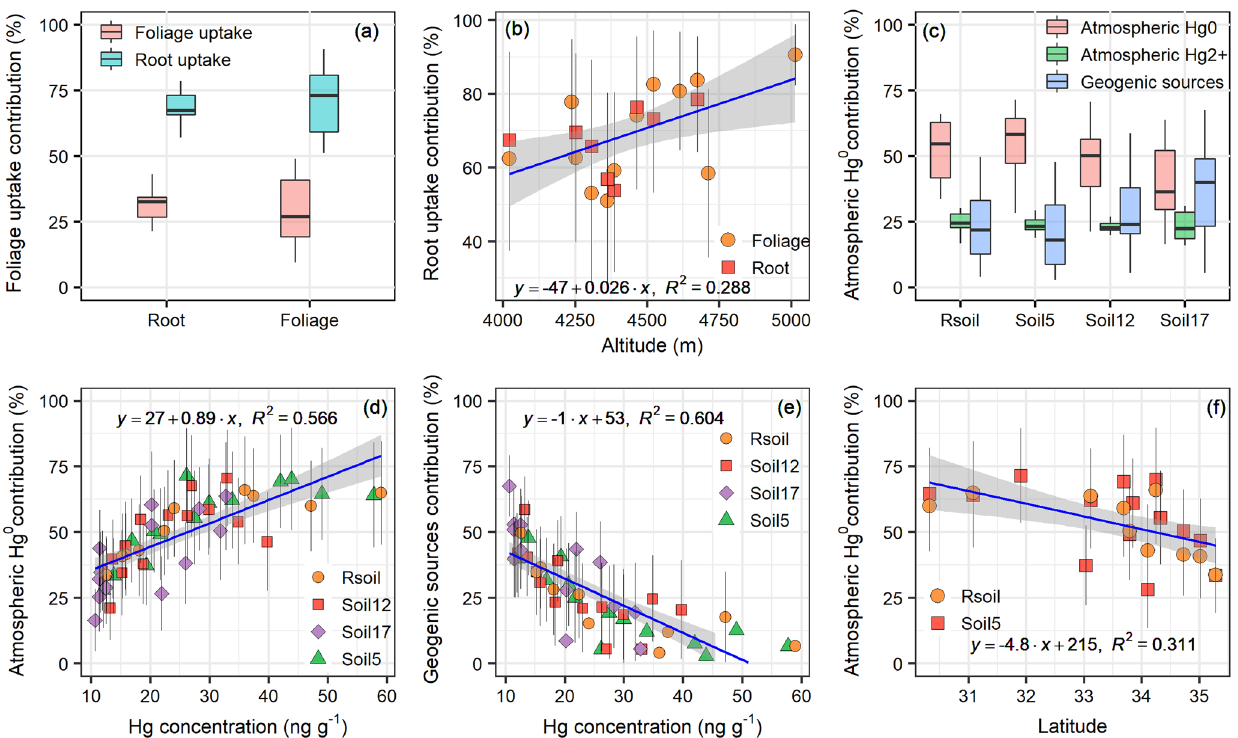
Fig. 4 Summary of estimates from the mercury (Hg) isotopic and source attribution model. a Source attribution using the Hg isotopic model for vegetation, b correlation for contribution of root uptake of soil Hg in vegetation versus altitude, c source attribution using the Hg isotopic model for soils, d correlation for soil Hg concentration versus foliage uptake of atmospheric Hg 0 sources in surface soil, e correlation for contribution of geogenic sources versus Hg concentration, f correlation for latitude versus foliage uptake of atmospheric Hg 0 sources. All regressions reach the signi fi cant level at the 95% con fi dence. Boxplot elements in a and c show the median (midline), the interquartile range of 25% and 75% percentile (box boundaries), data points within the 1.5 × quartile range (whiskers). The shading in b , d − f represents the 95% con fi dence interval for regression, and error bars stand for 1 σ